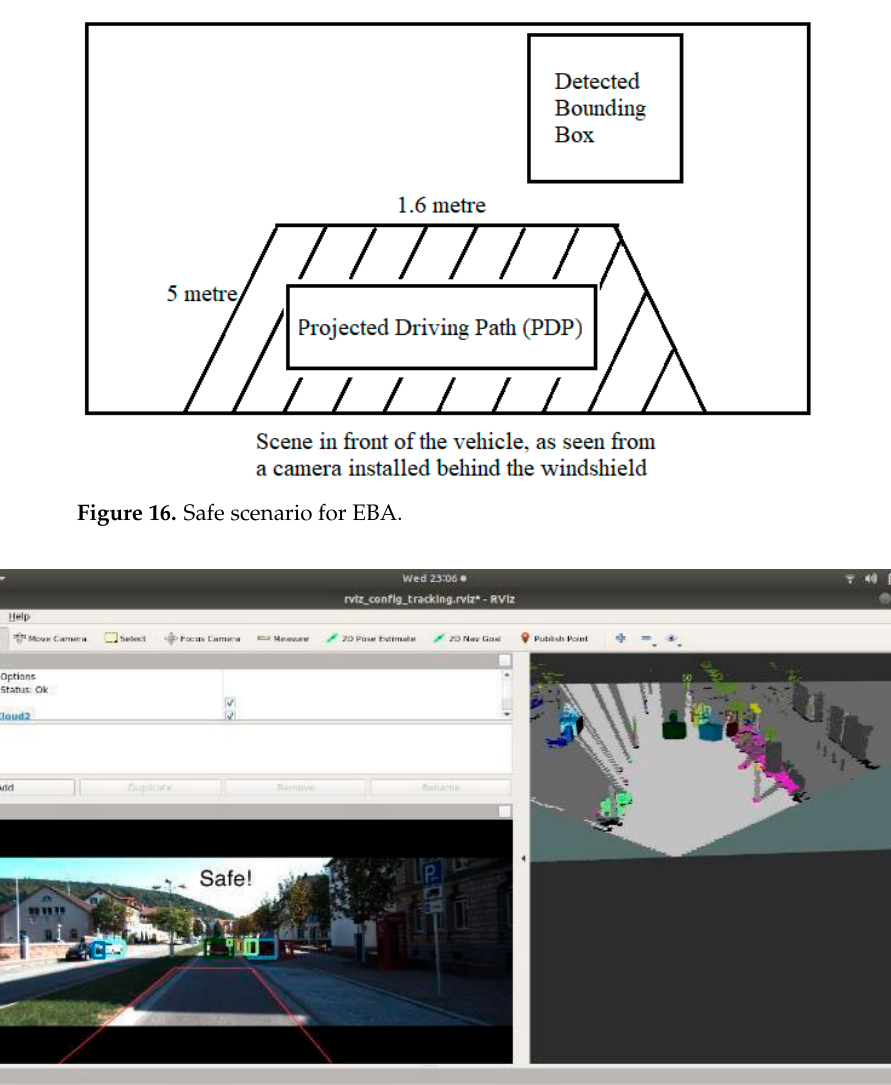
17 of 29 Figure 15. Flow chart for EBA functionality.